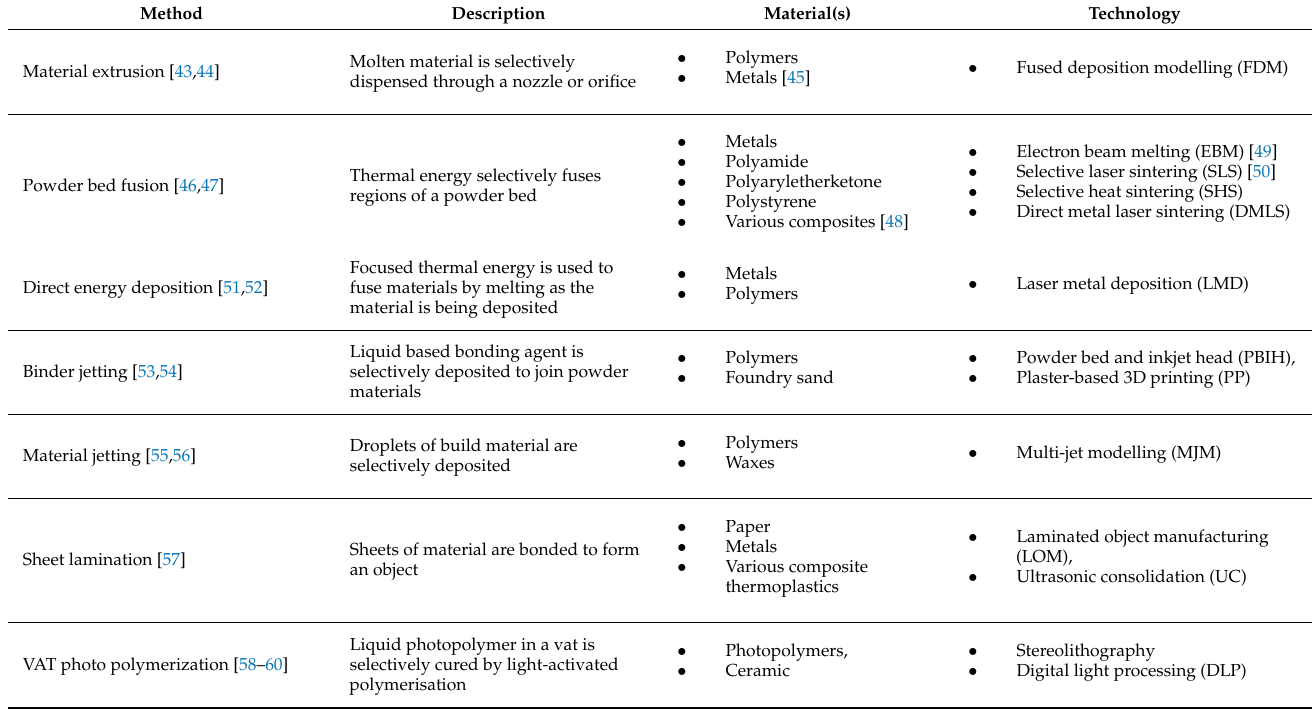
Table 1. Major types of additive